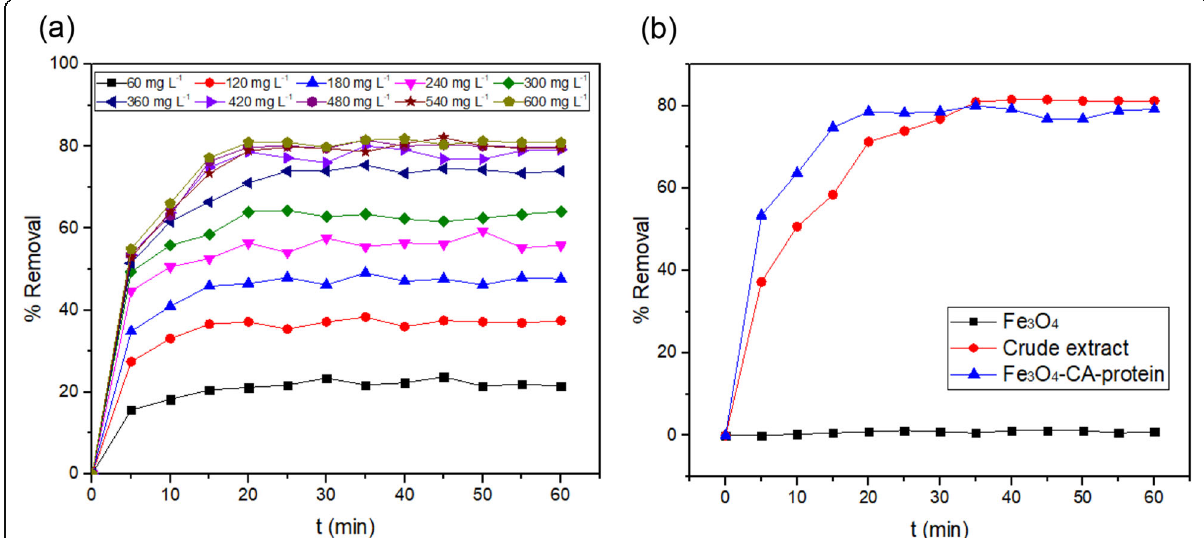
Fig. 5 Kinetics parameter of settling at various magnetic coagulant dosages ( a ) and comparison of magnetic coagulant (Fe 3 O 4 -CA-protein; 420 mg L − 1 ) to leucaena crude extract (370 mg eq BSA L − 1 ) and Fe 3 O 4 (50 mg L − 1 ) ( b )